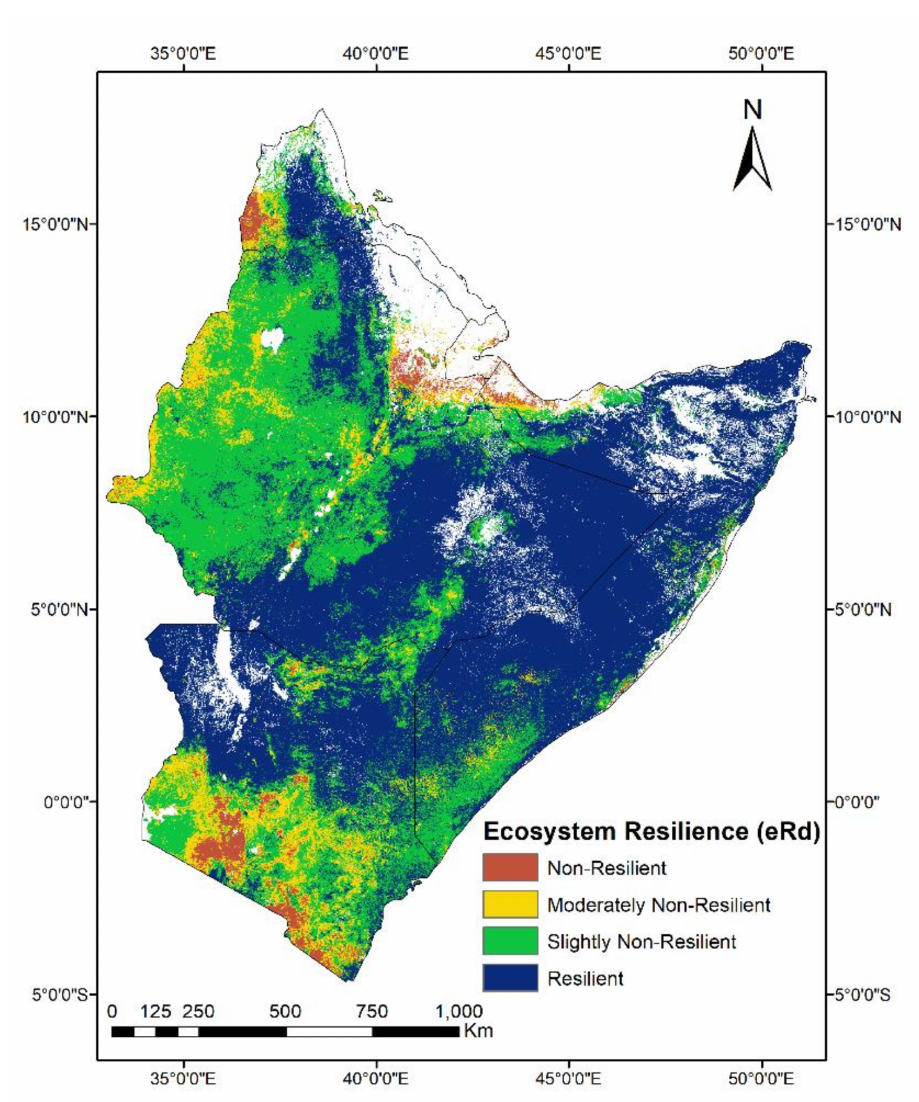
Figure 10. Ecosystem resilience (eRd) to drought based on eWUE in the Horn of Africa (2000–2014). We also integrated the final ecosystem resilience result with different land cover types and agroecological zones of the region. The cropland and wetland were slightly non-resilient to drought with mean eRd values of 0.97 and 0.99, correspondingly. While, grassland and sparse vegetation were relatively the most resilient to drought with mean eRd values of 1.12 and 1.1, respectively. Likewise, the tropic warm-humid with